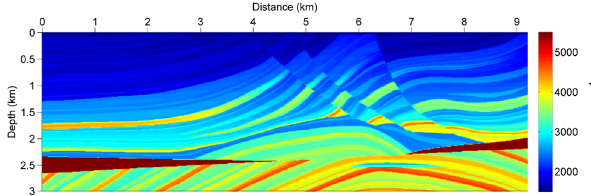
Figure 17. Marmousi velocity